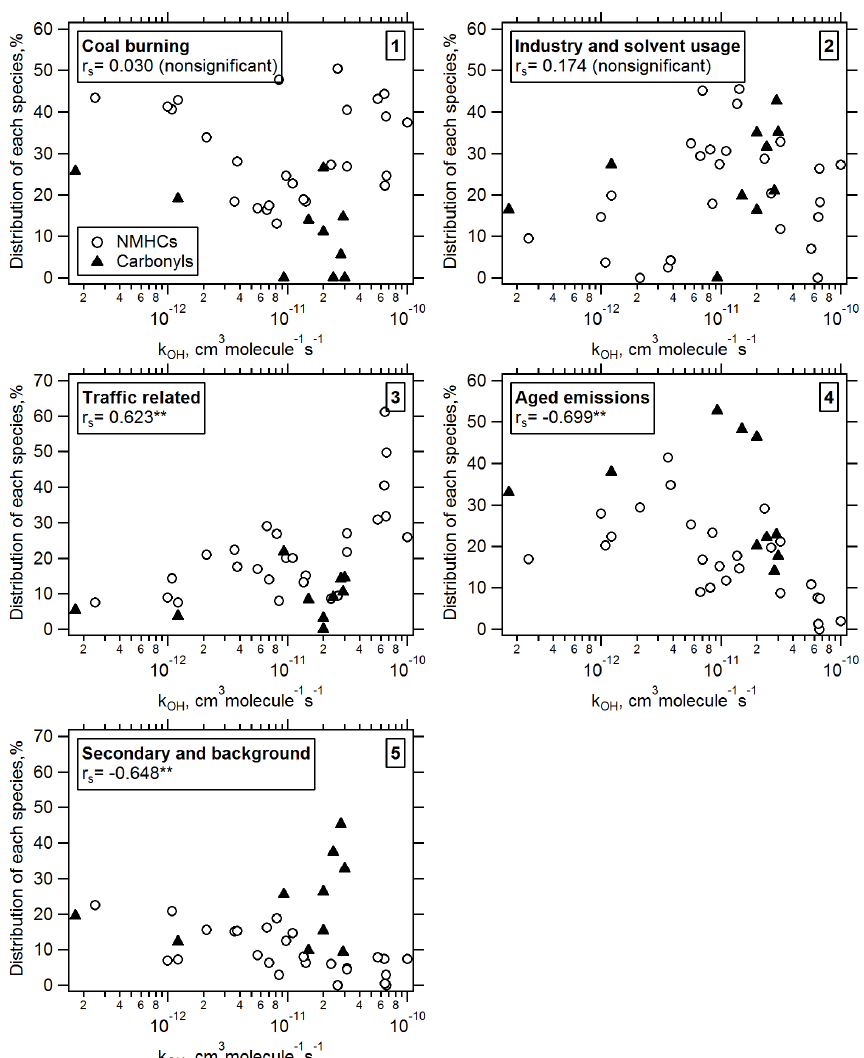
Fig. 5. Relationships between the factor contributions to each NMHC species and k OH values of NMHC species in winter. Each circle represents one compound. Carbonyls are shown as solid triangles in the graph, but they were not used for correlation analysis due to their secondary production. ∗∗ indicates a significant correlation at a confidence level of